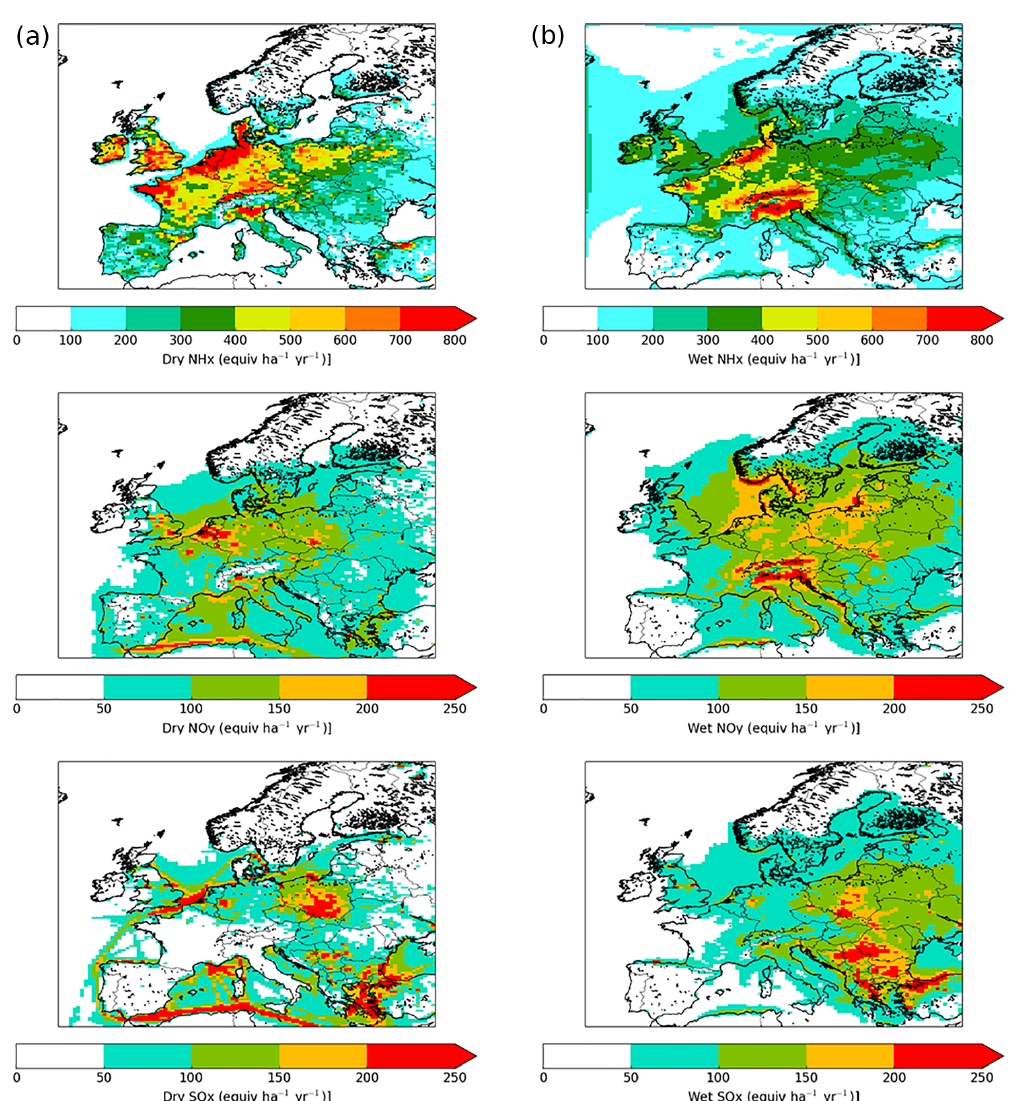
Figure 5. Modelled dry (a) and wet (b) deposition of reduced (top) nitrogen, oxidized (middle) and oxidized sulfur (bottom).